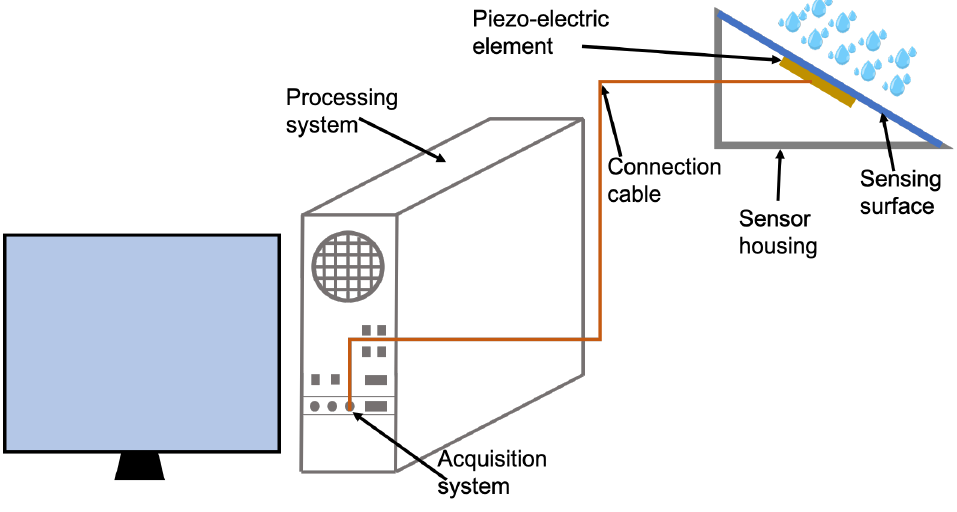
Figure 1. Prototype architecture of the